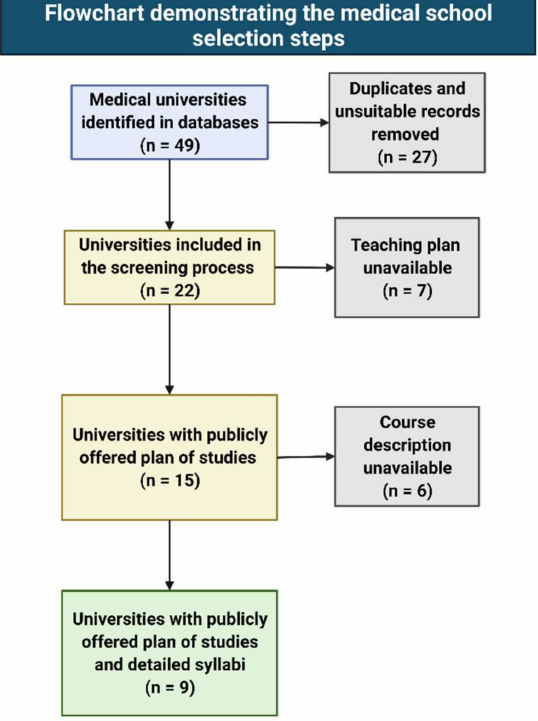
Figure 2. Selection steps during the analysis of course contents offered by the Polish medical